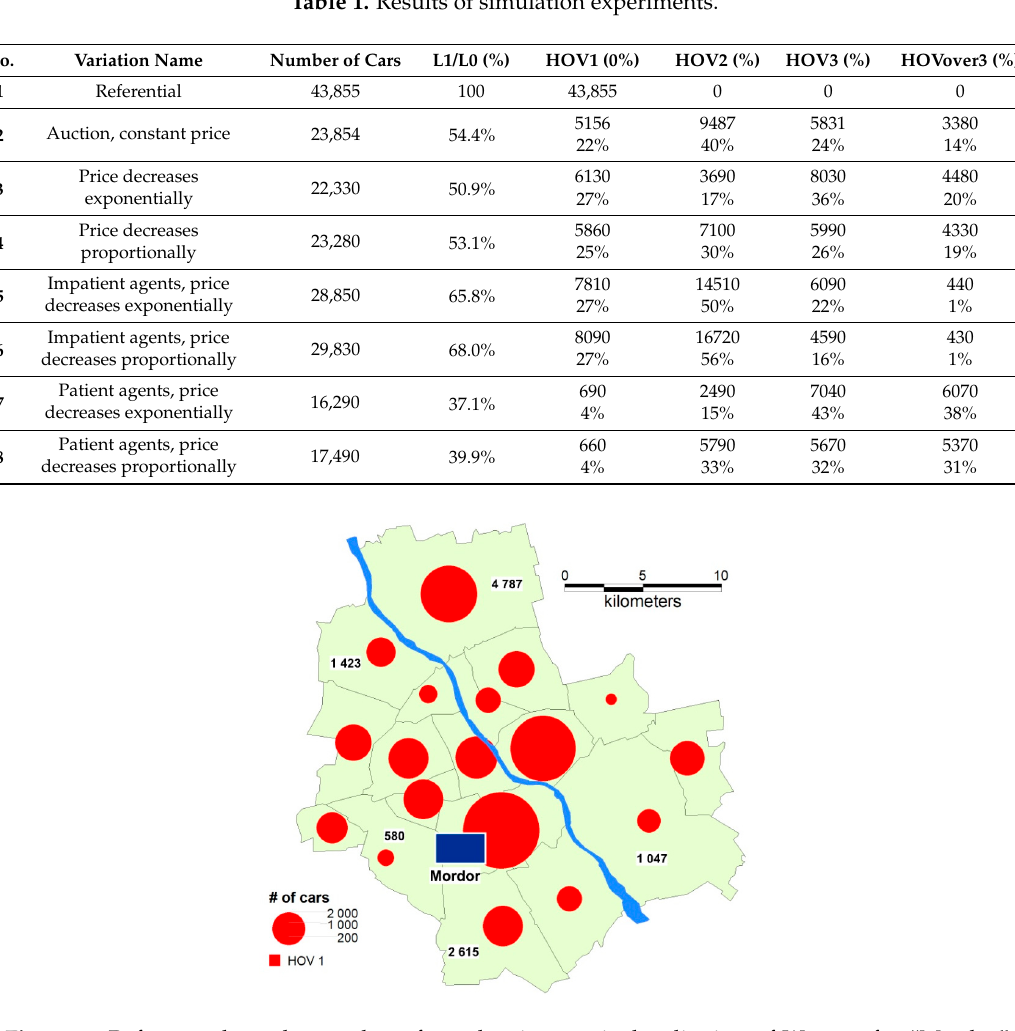
Figure 10. The number of cars (the number of passengers): a pie chart and the percentage change in the number of cars compared to the referential variation—a reference auction.